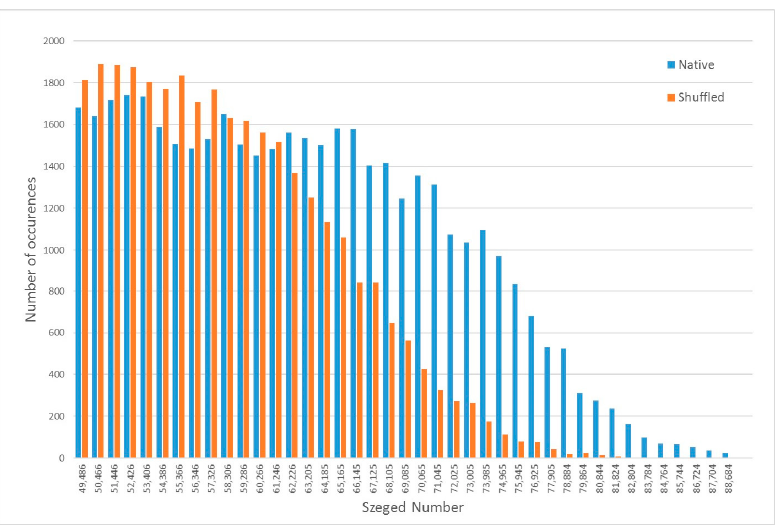
Figure 4. A histogram of the last 50 bins corresponding to the highest Szeged numbers of all RNA structures in our dataset (with the exception of multi-branch loops), which are native sequences, compared to their shuffled sequences obtained using shuffleseq from EMBOSS. Reported p -value (see text) is less than 0.0001.